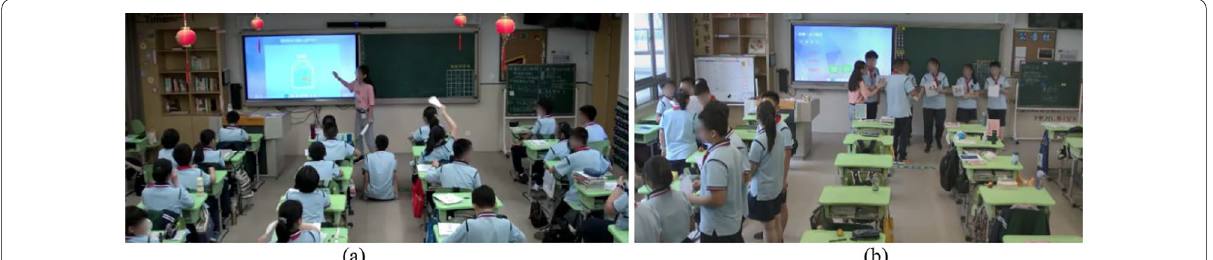
Fig. 2 Control class: IDL ( a ) and the experimental class: UPP ( b